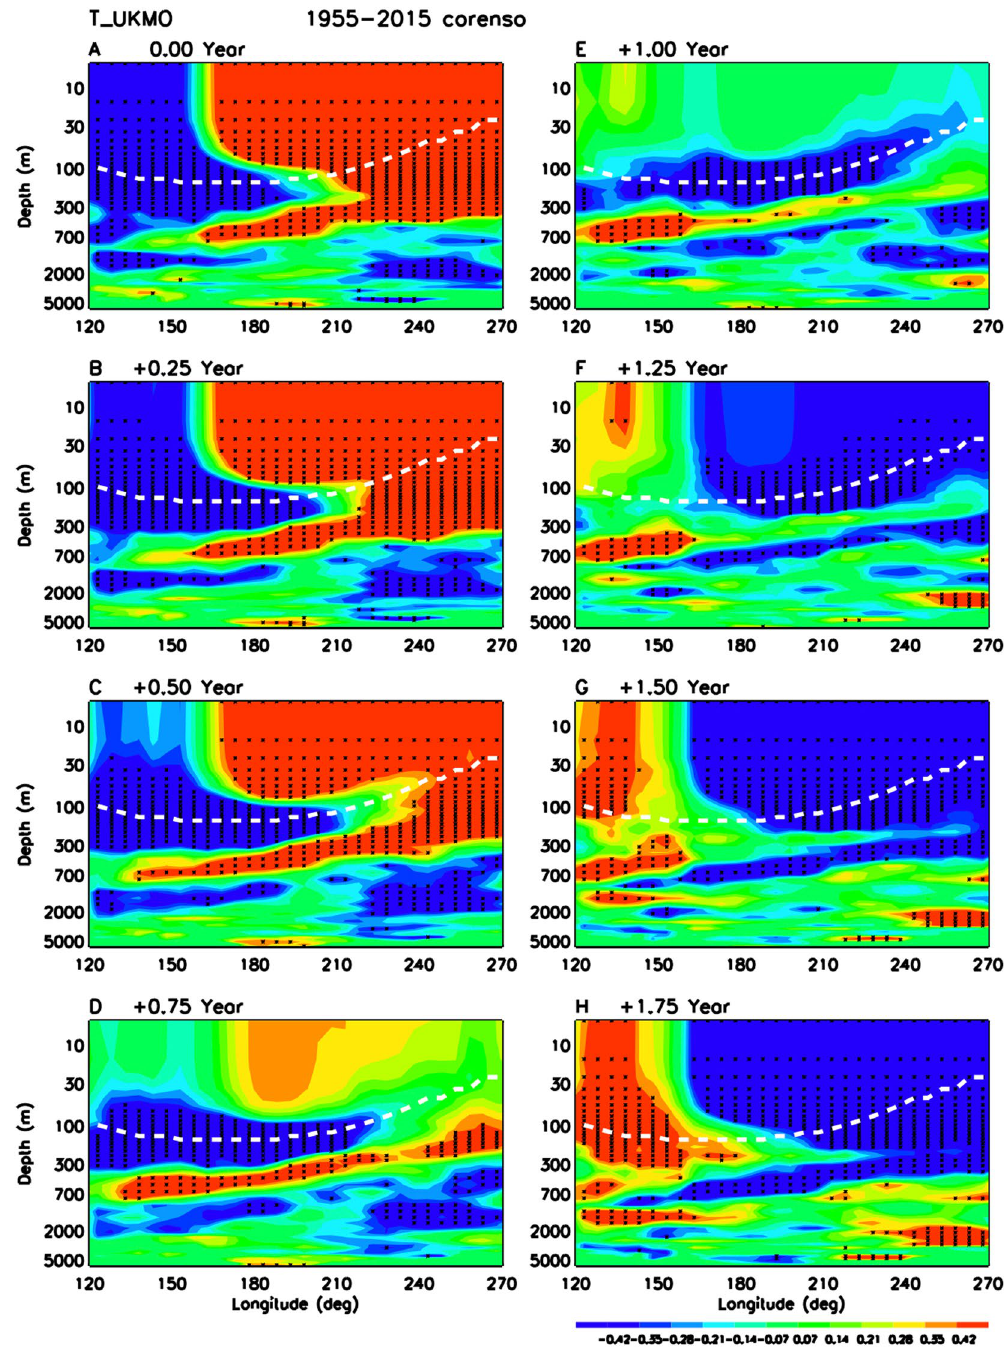
Figure 2. Same as Fig. 1 but for switch from El Nino to La Nina for ( A ) 0 month (El Nino) to ( H ) + 21 months after El